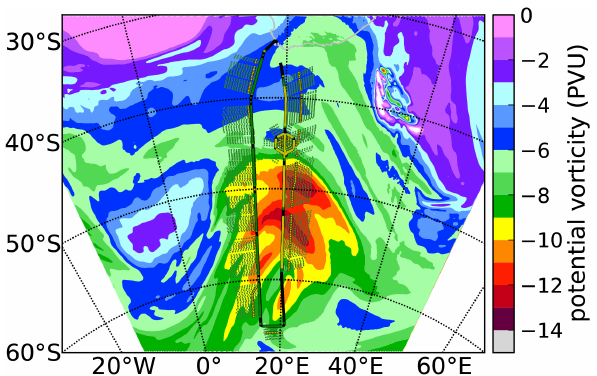
Figure 7. Meteorological situation during the ESMVal flight on 12 September 2012. Coloured areas indicate potential vorticity (PV) values at 12km altitude. The flight path is shown by the coloured line. Operation phases in the dynamics mode and chemistry mode are shown in yellow and green, respectively. The tomographic mea- surement, indicated by the hexagon, was made in an area of strong wave activity as reflected in the PV field.